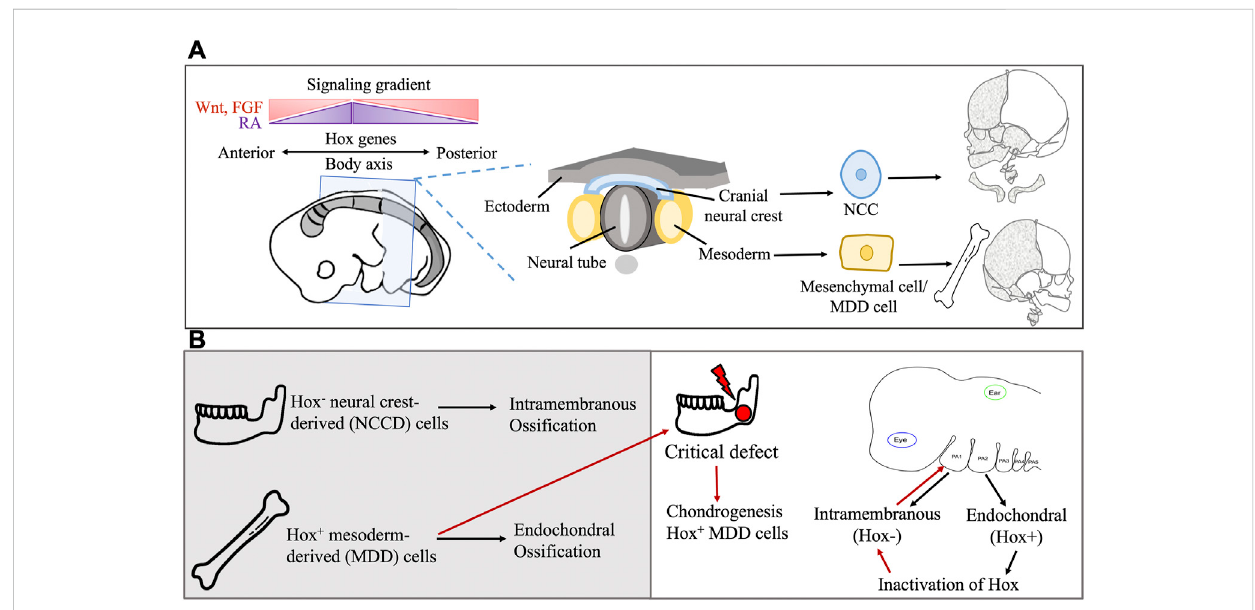
FIGURE 3 (A) Embryonic origin of extracranial and craniofacial bone and the role of Hox genes in directional differentiation. Hox genes also interact with regulatory gene, transcription factors and signaling molecule gradient for patterning of the body axis. (B) The Hox gene confers spatial regulation and affects the type of bone ossi fi cation during development and transplantation in bone